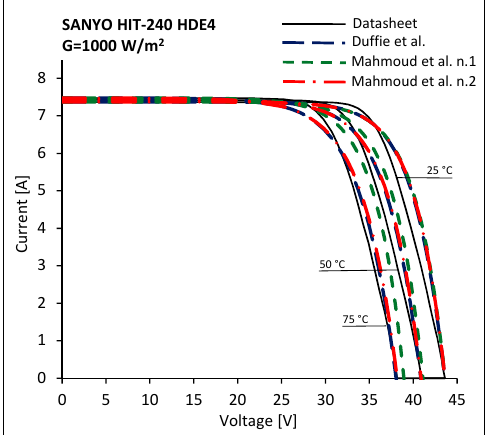
Figure 16. Comparison between the issued I-V characteristics of the Sanyo HIT-240 HDE4 at G = 1000 W/m 2 and the characteristics calculated by means of the Duffie et al. and the Mahmoud et al. models.